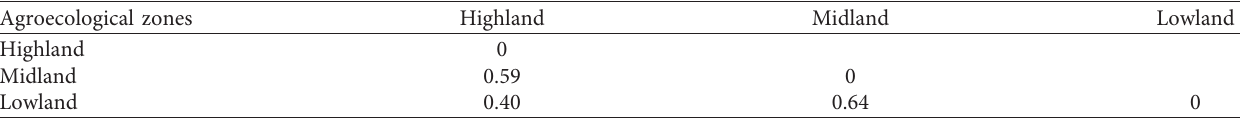
Table 4: Species composition similarity among agroecological zones and wealth category using Sorensen’s similarity index in the study area. Agroecological zones